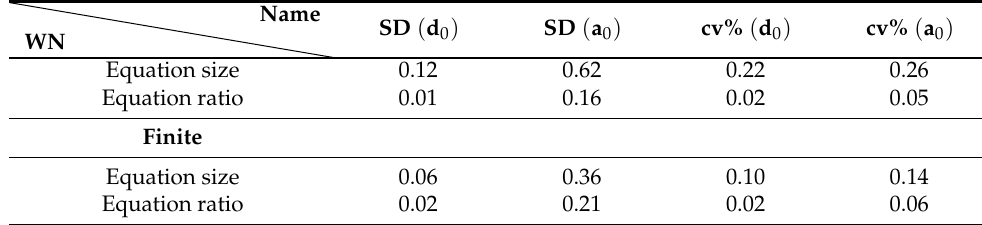
Table 3. The coefficient of variation of characteristic length.